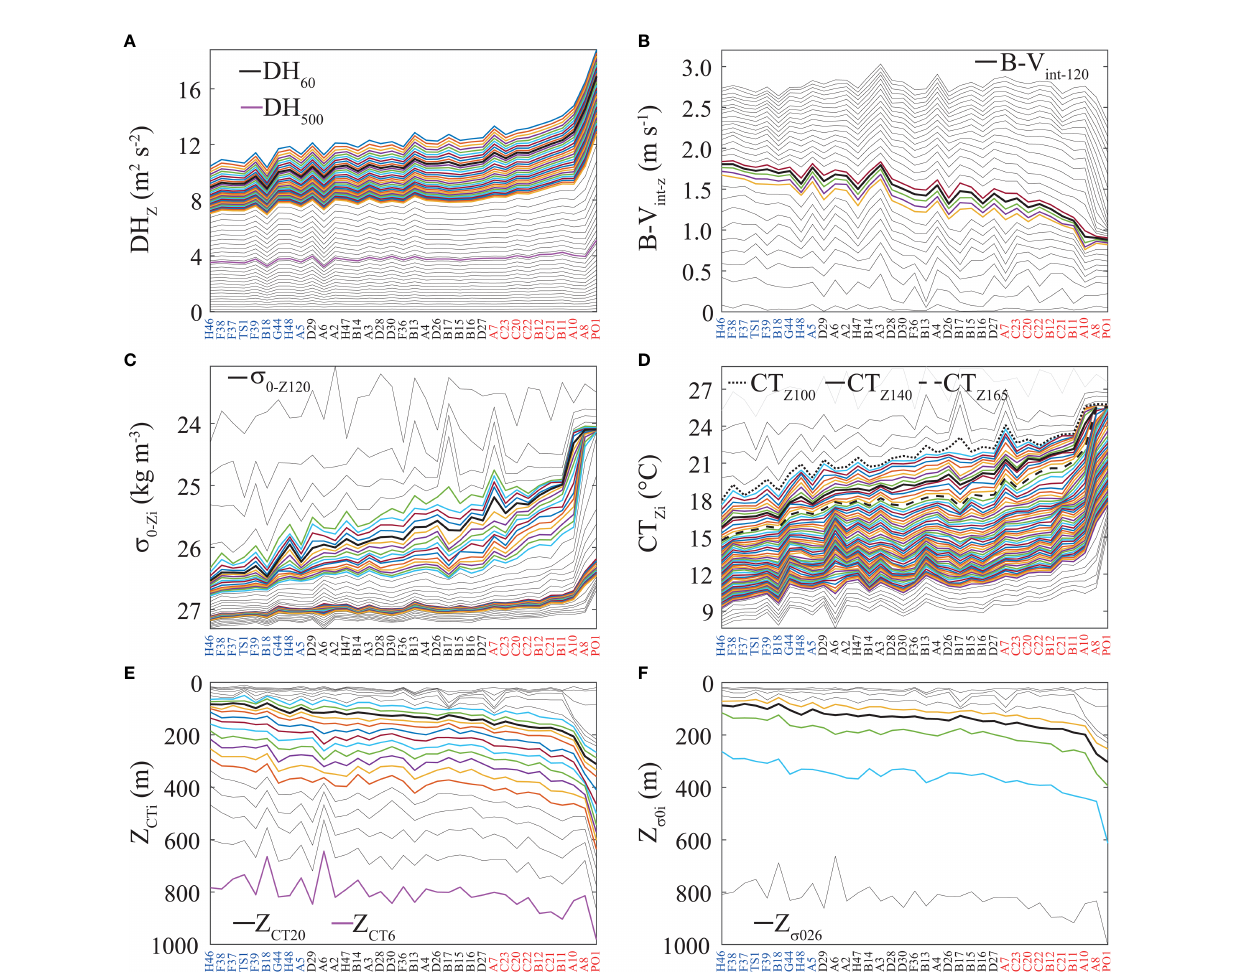
FIGURE 4 | Best fi t variables (BFVs) and the intervals explored for each variable. (A) Dynamic height (DH z , m 2 s -2 ) anomaly integrated from 1000 – 15, 1000 – 20, and so on up to 1000 – 995 m. (B) Brunt-Väisälä frequency integrated (B-V int-z , m s -1 ) over 15 – 20, 15 – 25, and so on up to 15 – 300 m. (C) Potential density anomaly ( s 0-Zi , kg m -3 ) and (D) Conservative Temperature (CT Zi , °C) in depths of 15, 20, 25, and so on up to 500 m. (E) Depth of the 6, 7, and so on up to 28°C isotherms (Z CTi , m). (F) Depth of the 23.5, 24.0, and so on up to 27.5 kg m -3 isopycnals (Z s 0i , m). The colored lines represent the best fi t intervals for each BFV and preserve the interval separation ( Table 1 ). To facilitate visualization, the thin black lines of some BFVs were plotted with different separations at the intervals de fi ned in Table 1 with separations of (A) 30 m, (B) 10 m, (C) 20 m, and (D) 20 m. The thick black line is the BFV. The magenta lines in Panels (A, E) correspond to DH 500 and Z CT6 , respectively. The stations labeled blue, black, and red correspond to the cyclonic (CE), no eddy (NE), and anticyclonic (AE) groups, respectively. The stations were ranked based on NN int-200 from highest (H46) to lowest (PO1). Note that in Panels (C, E, F) , the ordinate axis is